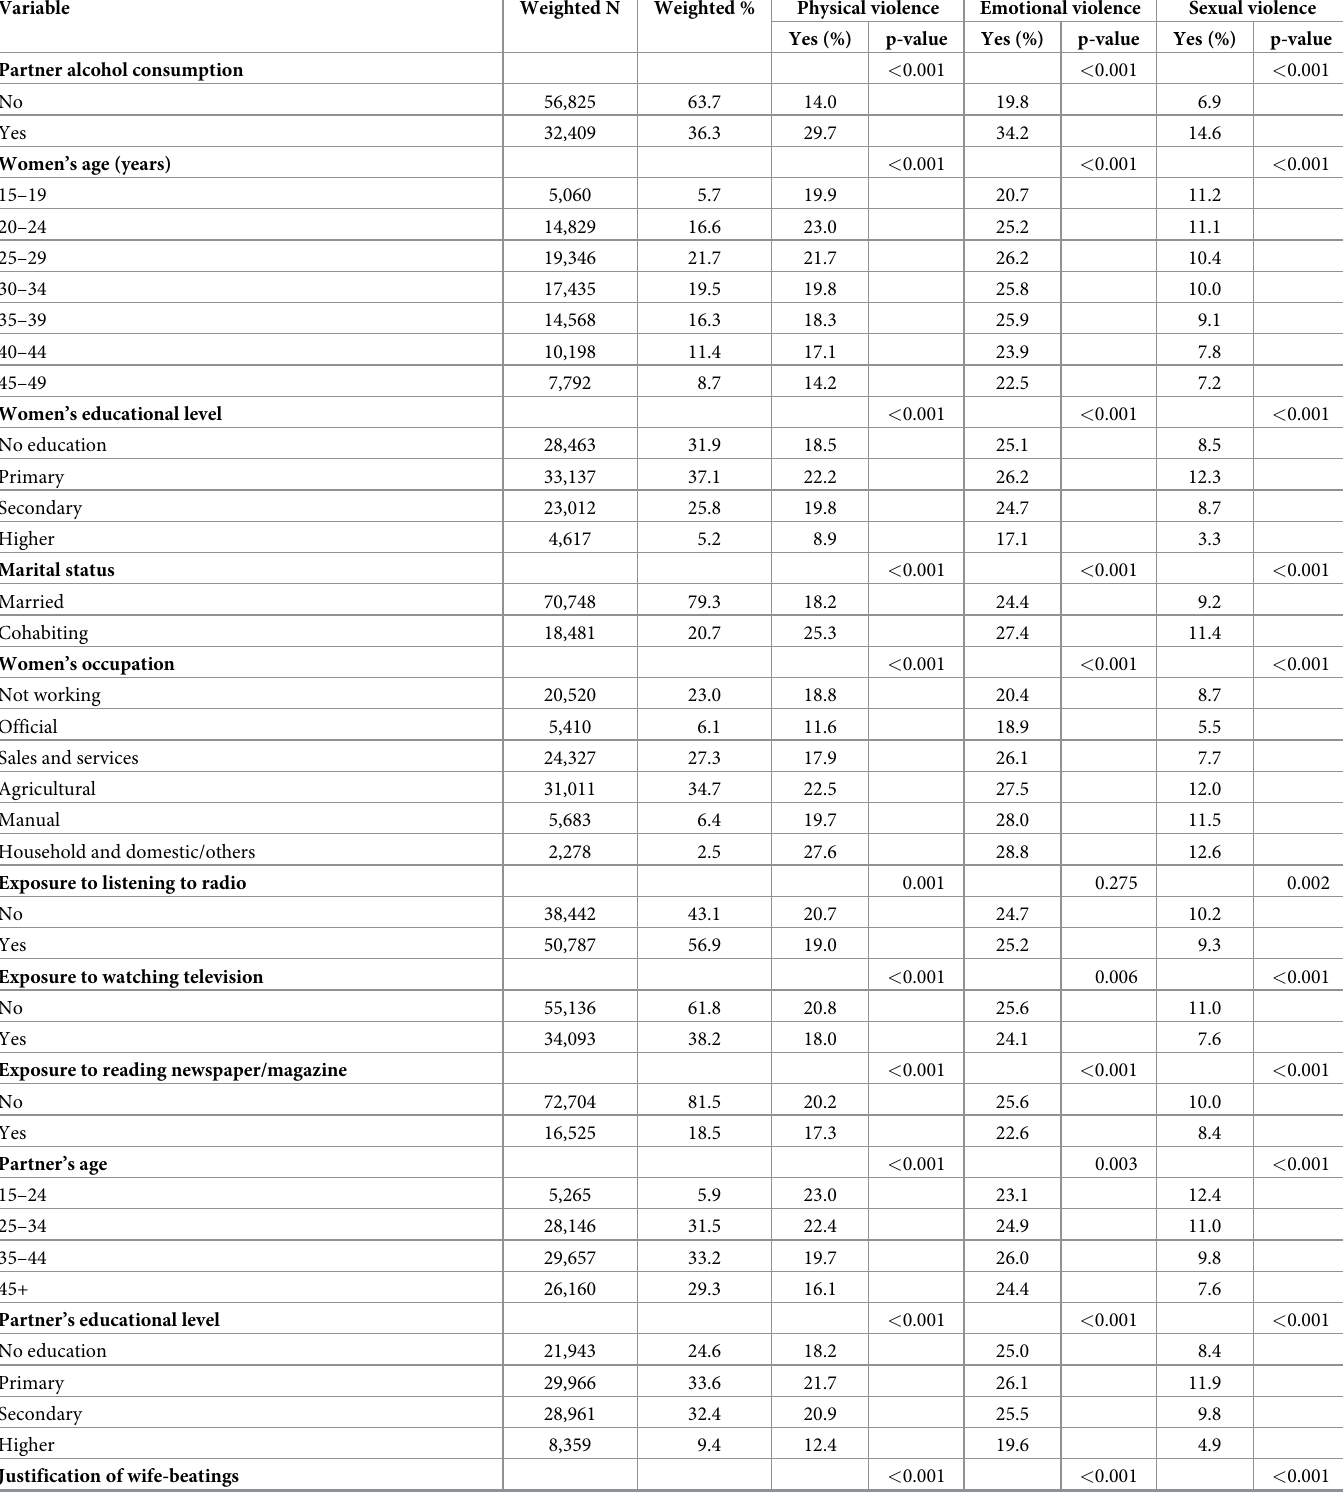
Table 3. Distribution of intimate partner violence across the explanatory